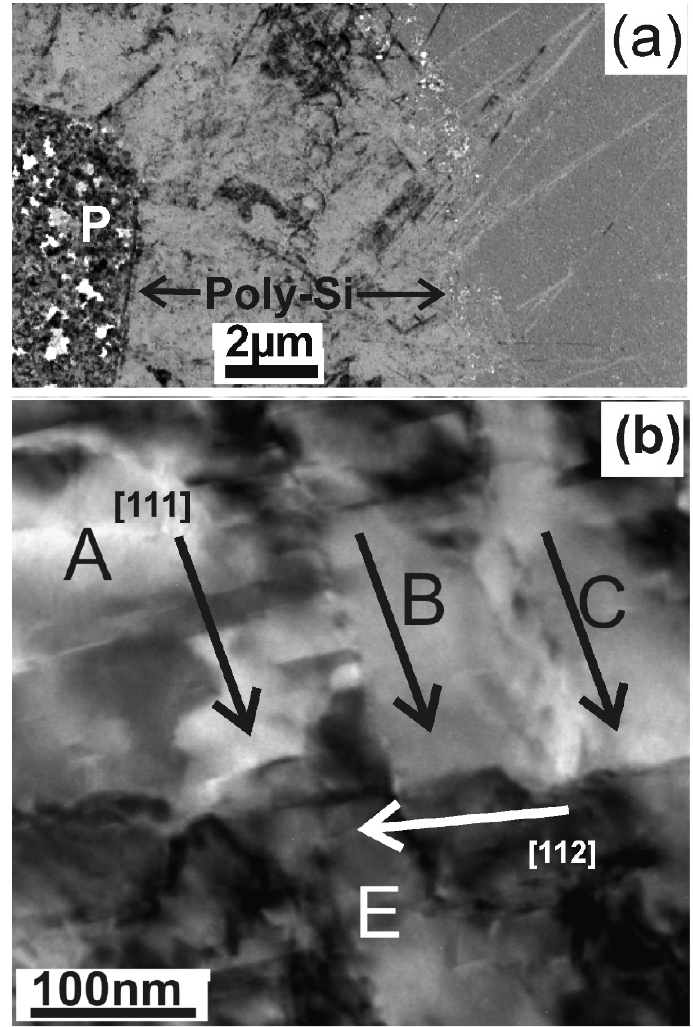
Figure 3. TEM micrographs from Ni-MILC at 413 ◦ C where SPC is completely suppressed. ( a ) Overall view of the structure around the pad denoted by the letter P. A continuous poly-Si film consisting of a mixture of fast and slow whiskers resulting in a tweed-like structure is extended up to 8 µ . Then, long fast [111] type whiskers emanate due to growth–death competition mechanism. ( b ) The tweed-like structure shown at higher magnification.